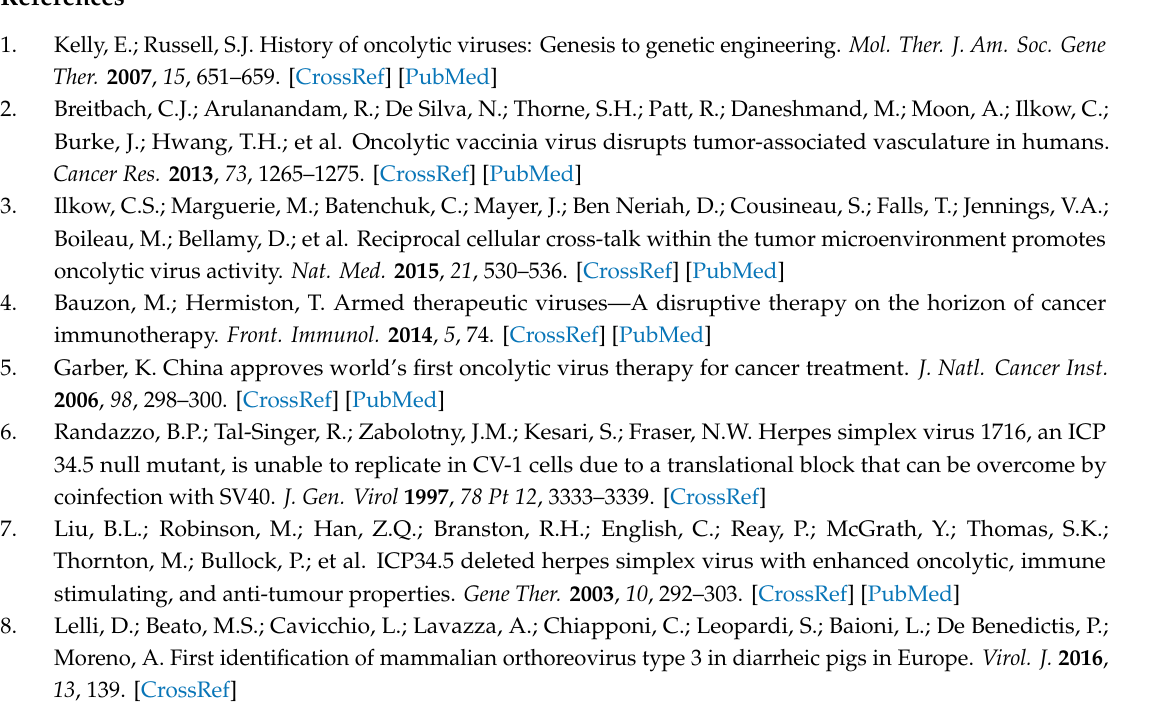
graphical abstract and T.B., prepared the figures, the clinical trial table and reviewed the manuscript. E.I. and F.E.-M. were responsible for the conceptual design of the article. All authors have read and agreed to the published version of the